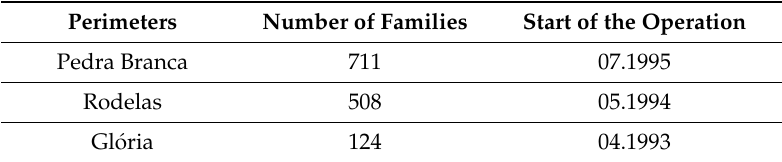
Table 5. Irrigation perimeters of the Itaparica System located in the State of